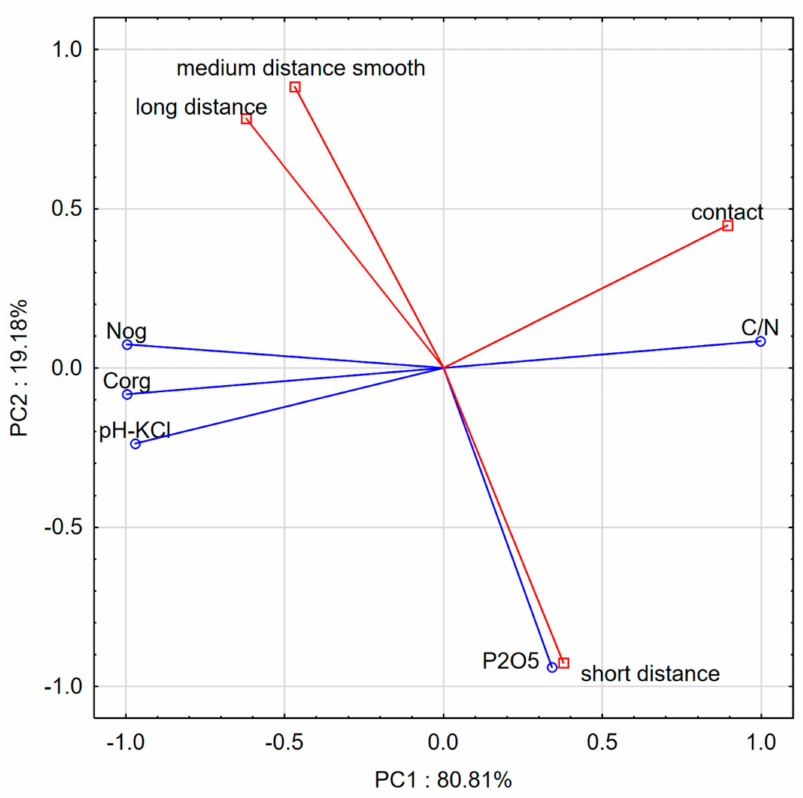
Figure 5. Principal component analysis (PCA) of di ff erent ectomycorrhizae exploration types observed on Q. robur roots, and selected soil